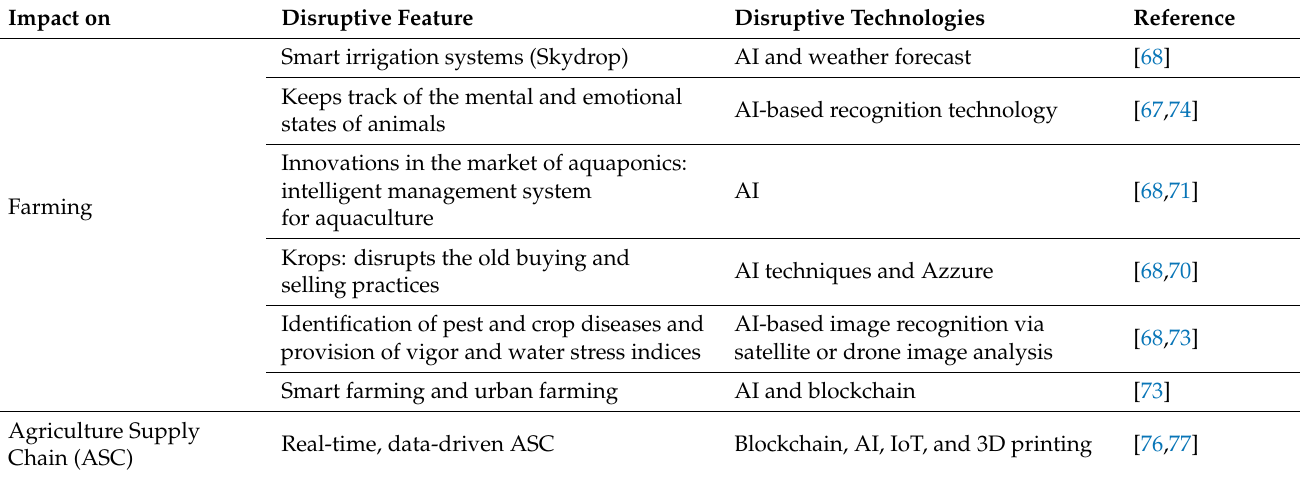
Table 10. Disruptive use of AI and additional technologies with respect to